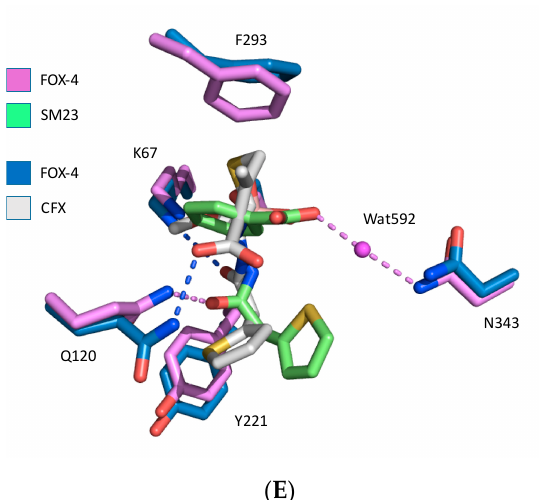
Figure 2. Structures of FOX-4, apo and bound to CEF BATSI (SM23). ( A ) Conformational changes in only F293 and L119 side chains occur upon binding to ligand. The thiophene ring of SM23 does not interact appreciably with Y221. ( B ) Water molecules bridge interactions between the protein (T316, S318, and N343) and borate / carboxylate of the ligand. ( C ) E. coli AmpC bound to SM23 (PDB: 1MXO) shows an extensive hydrogen bonded network around N346 and N289. ( D ) SM23 binding modes in FOX-4 (pink) and AmpC (blue) show minor repositioning due to changes in F293 / L119 rotation. ( E ) Overlay of FOX-4 structures with SM23 (violet and green) and cefoxitin (blue and white, PDB: 5CGX). Dashed lines indicate hydrogen bonds. Water 592 appears in the SM23 structure only. Carboxylate of SM23 binds in canonical pocket (N343), whereas carboxylate of cefoxitin binds to Q120.